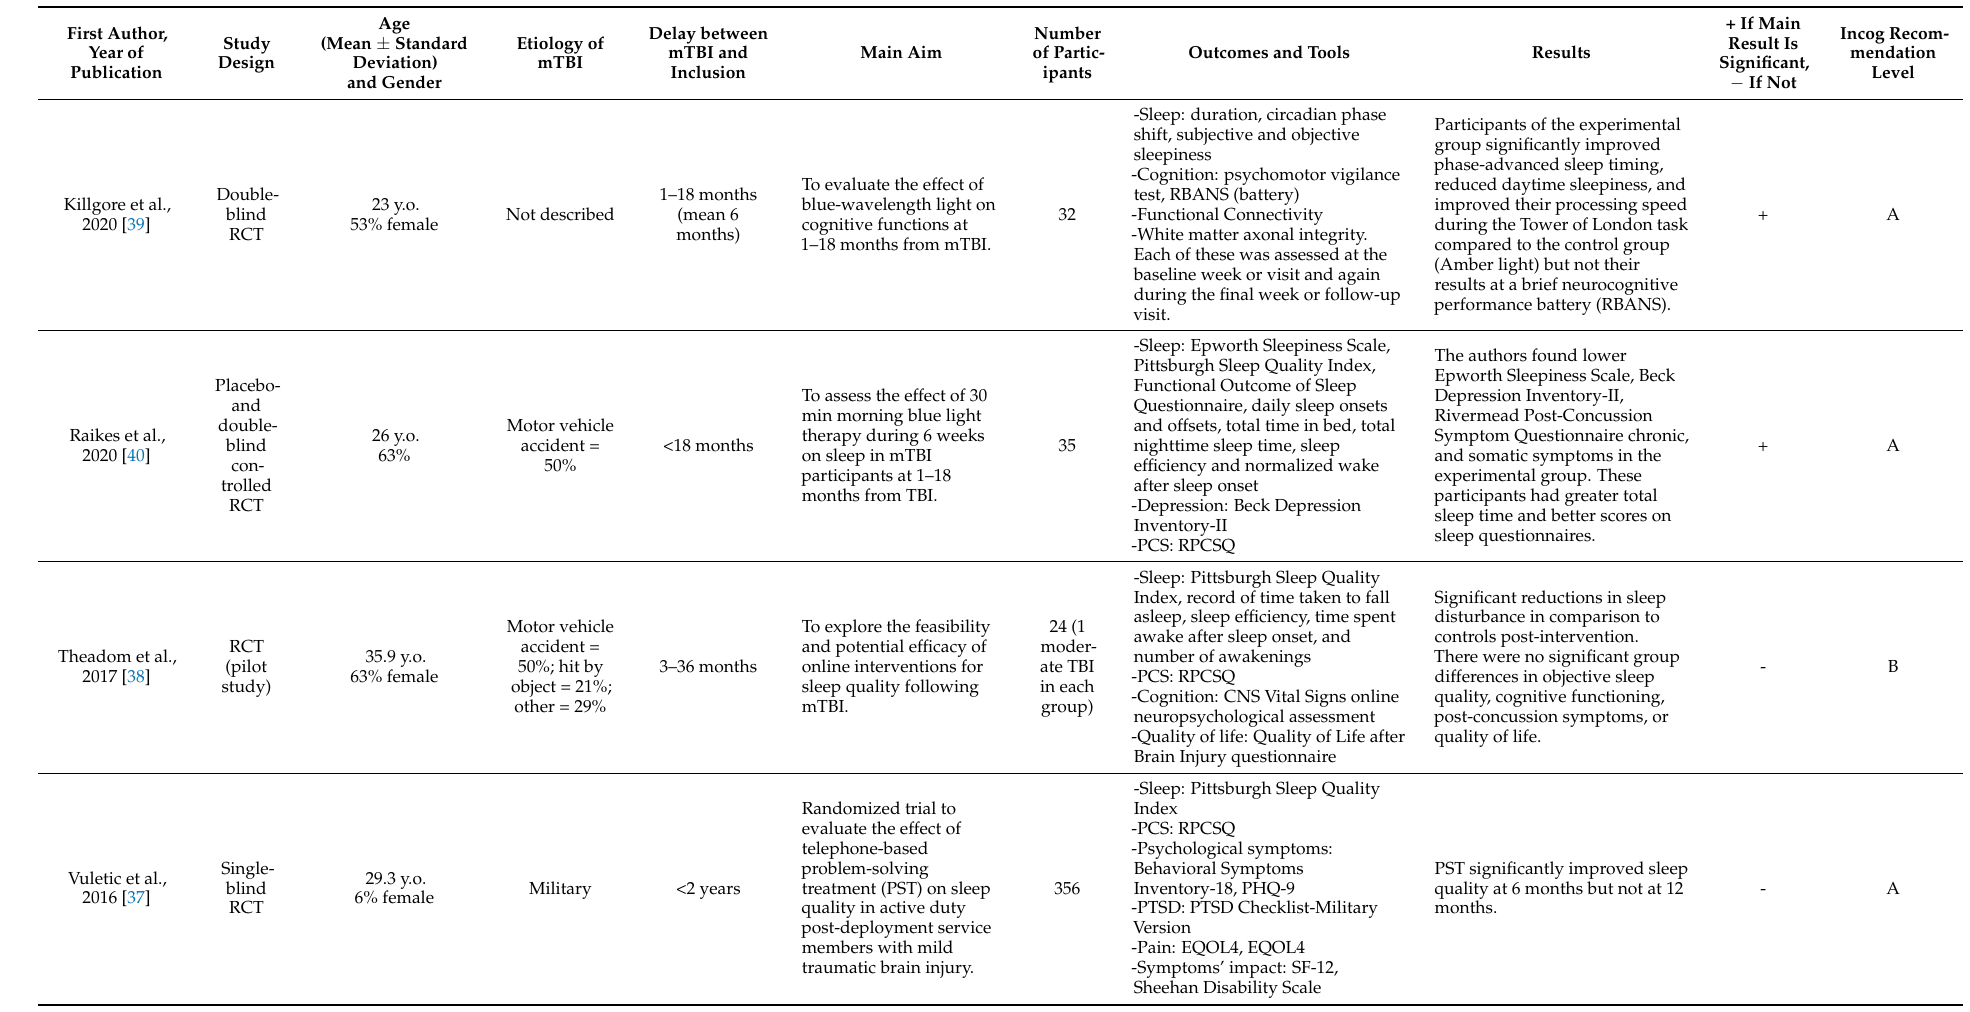
Table A2. Sleep (four